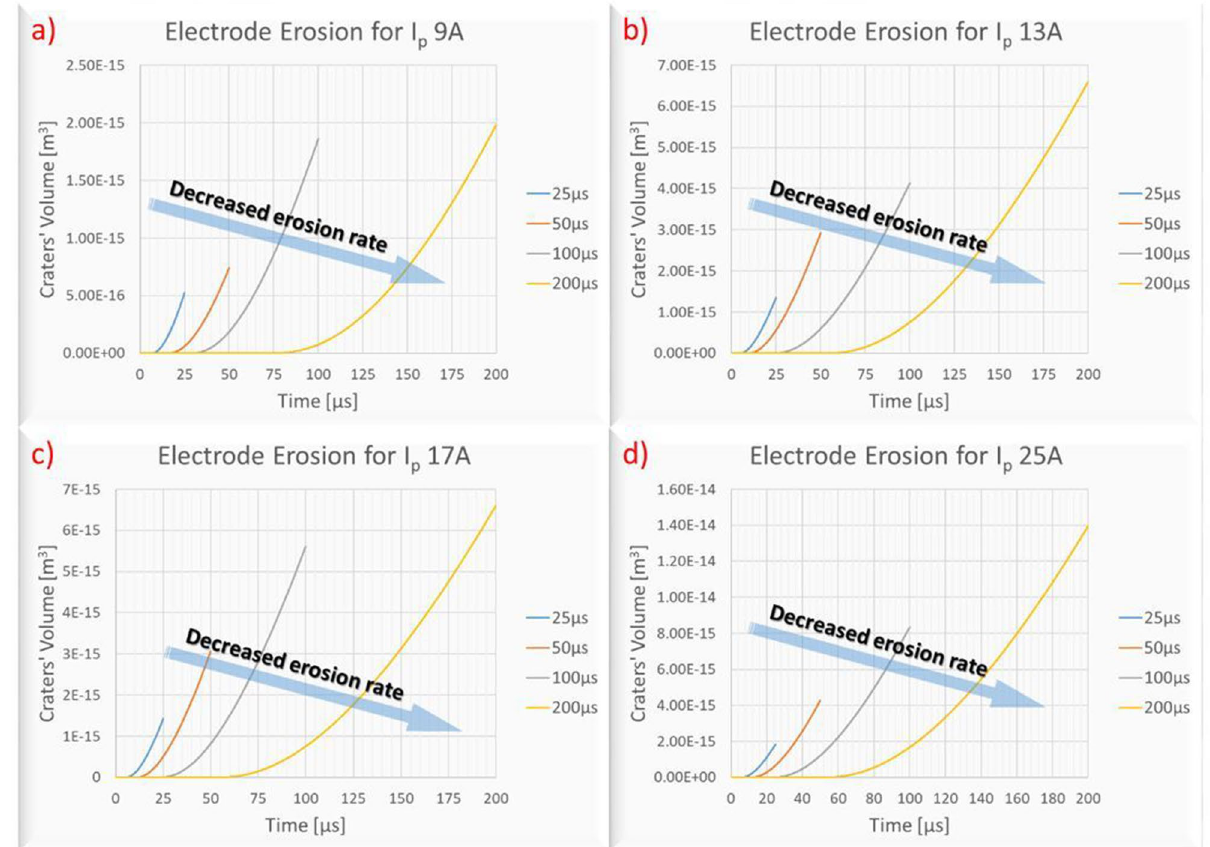
Figure 18. Erosion rates for different machining parameters for ( a ) 9A, ( b ) 13A, ( c ) 17A and ( d )